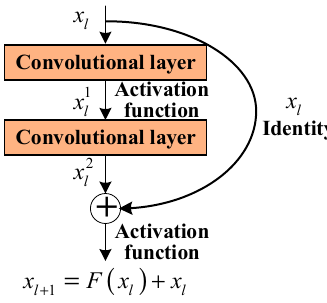
Figure 2. Schematic diagram of residual block.